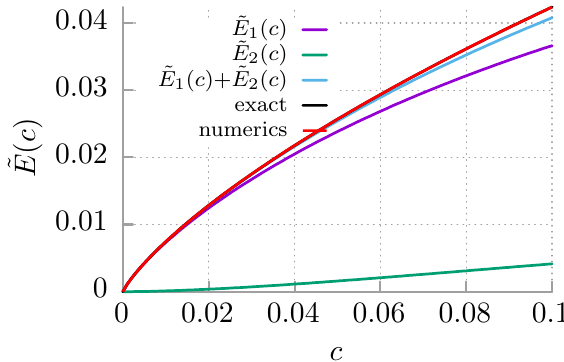
˜ E ( c ) of the free quantum Brownian particle in the limiting case of weak ˜ ˜ ˜ E 1 ( c ) and E 2 ( c ) to E ( c ) are